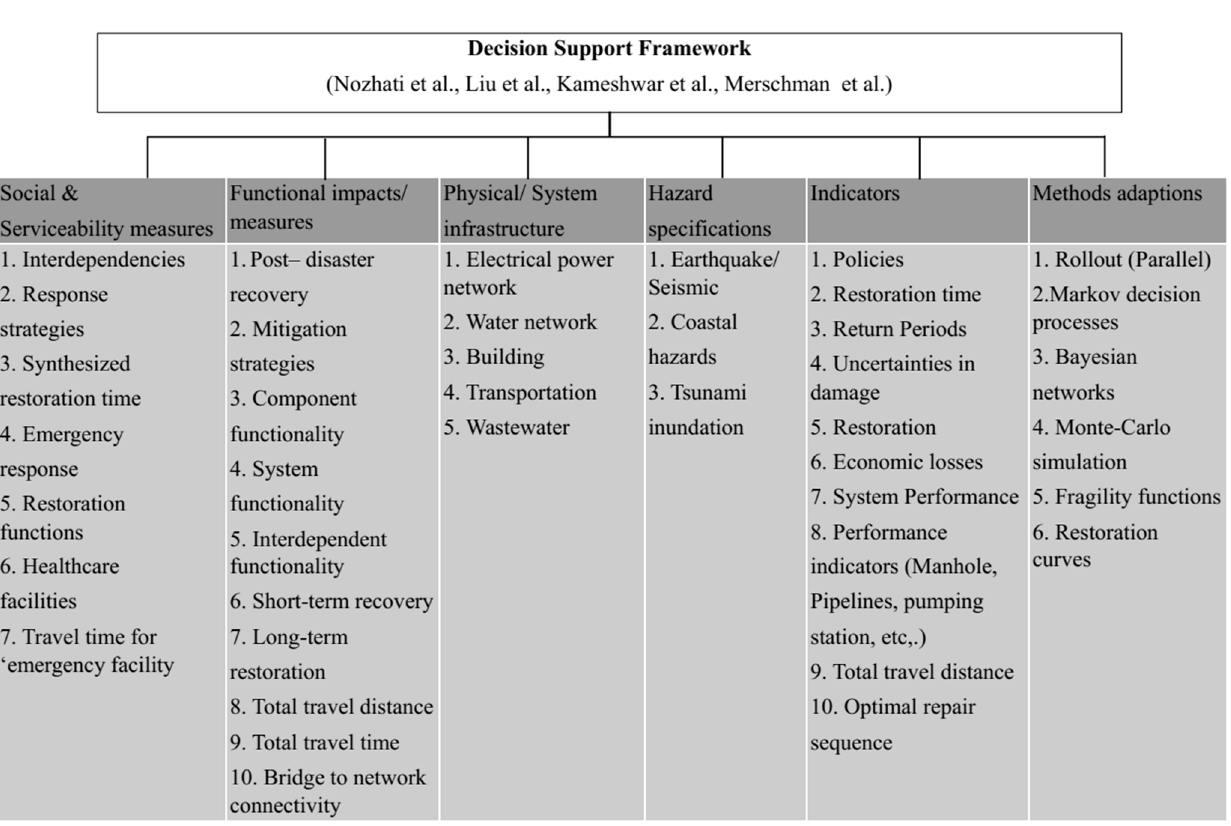
Figure 7. Attributes of the decision-based framework from past studies in terms of social, functional, and physical metrics, taking into account the indicators and methodology used.